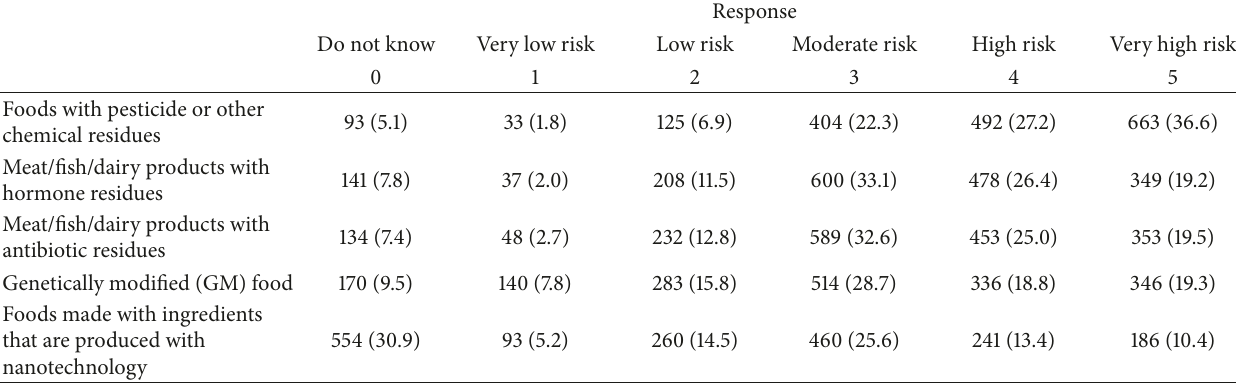
Table 3: Frequency distribution of ratings of concern about potential issues of food integrity: 2017 sample ( N =